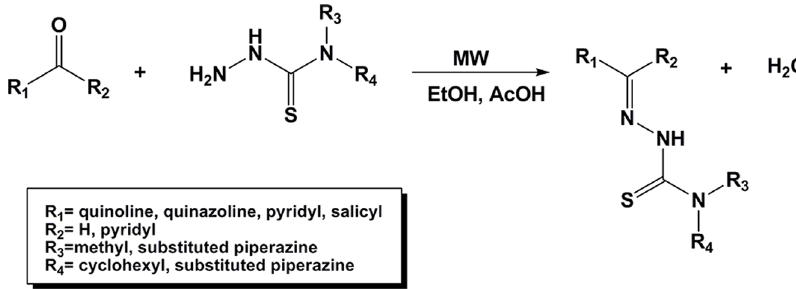
Figure 4. Synthetic route to yield the final thiosemicarbazones.